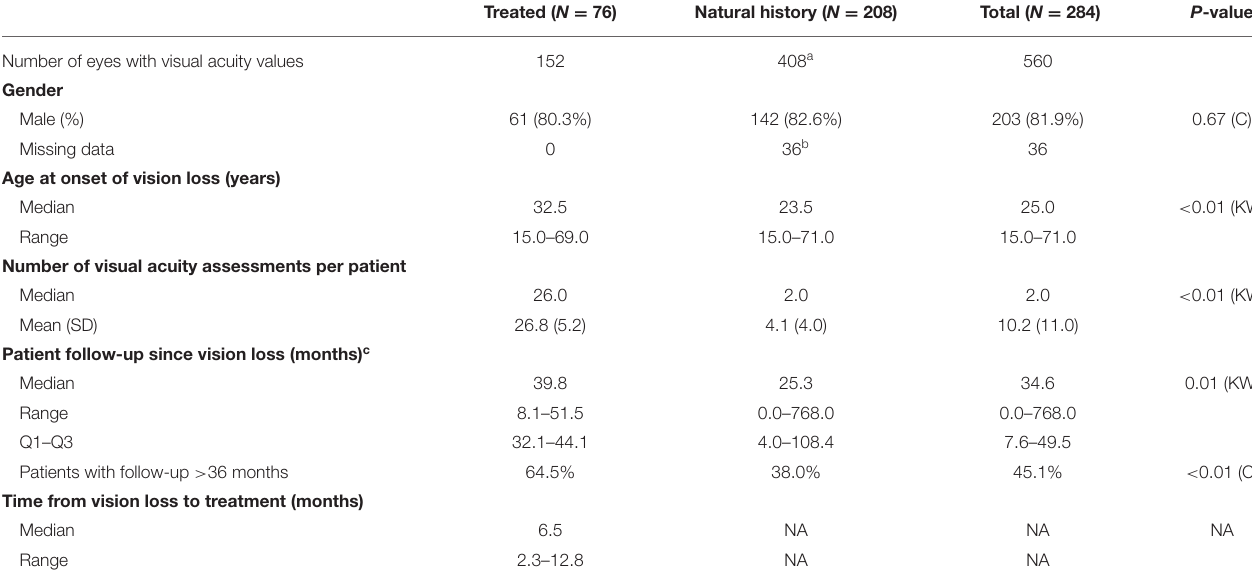
TABLE 1 | Description of the